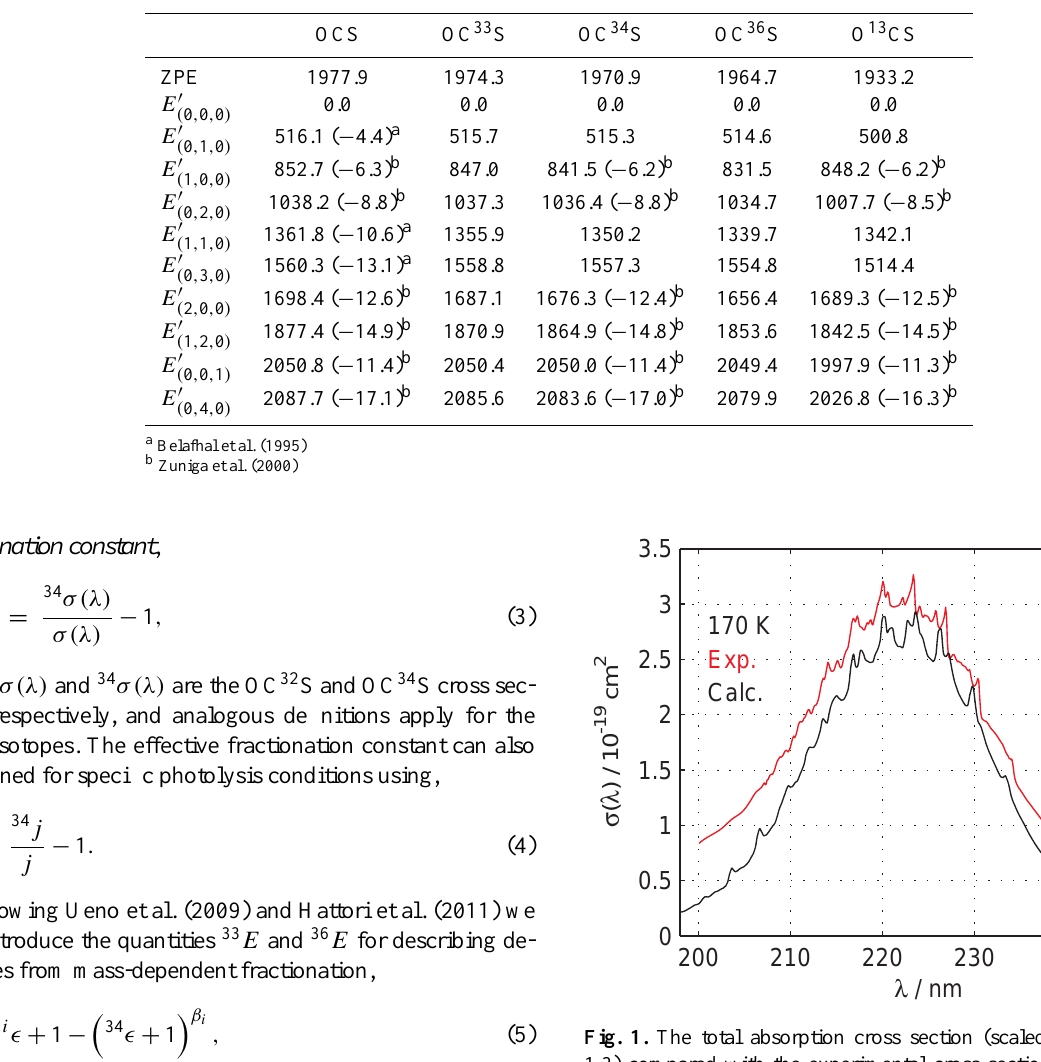
Fig. 1. The total absorption cross section (scaled by a factor of 1.3) compared with the experimental cross section of Robert Wu et al. (1999). The temperature in the calculation and measurement is 170K. The experimental cross section was shifted up by 0.25 for